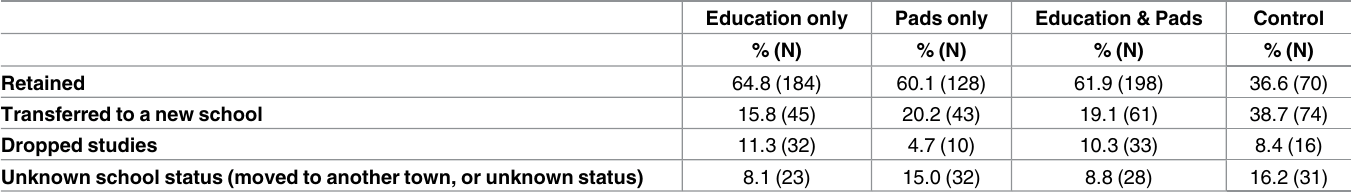
Table 1. School status at follow-up according to condition (n = 1008).